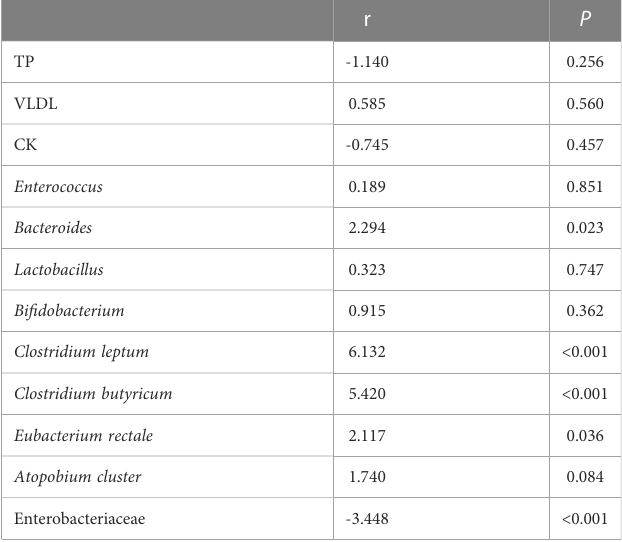
TABLE 4 Multivariate linear regression analysis of Faecalibacterium prausnitzii and metabolic indicators and other gut microbiota. r P TP -1.140